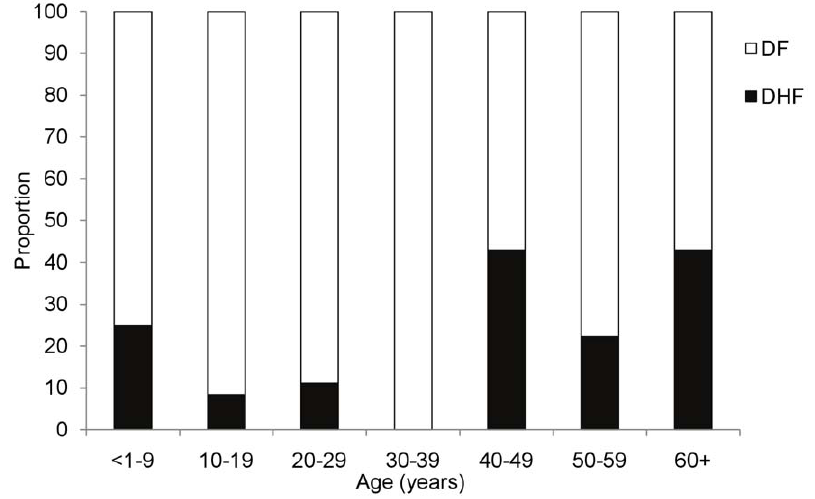
Figure 2. Proportion of DF and DHF cases in the case-control study by age-group. doi:10.1371/journal.pone.0013729.g002 PLoS ONE |